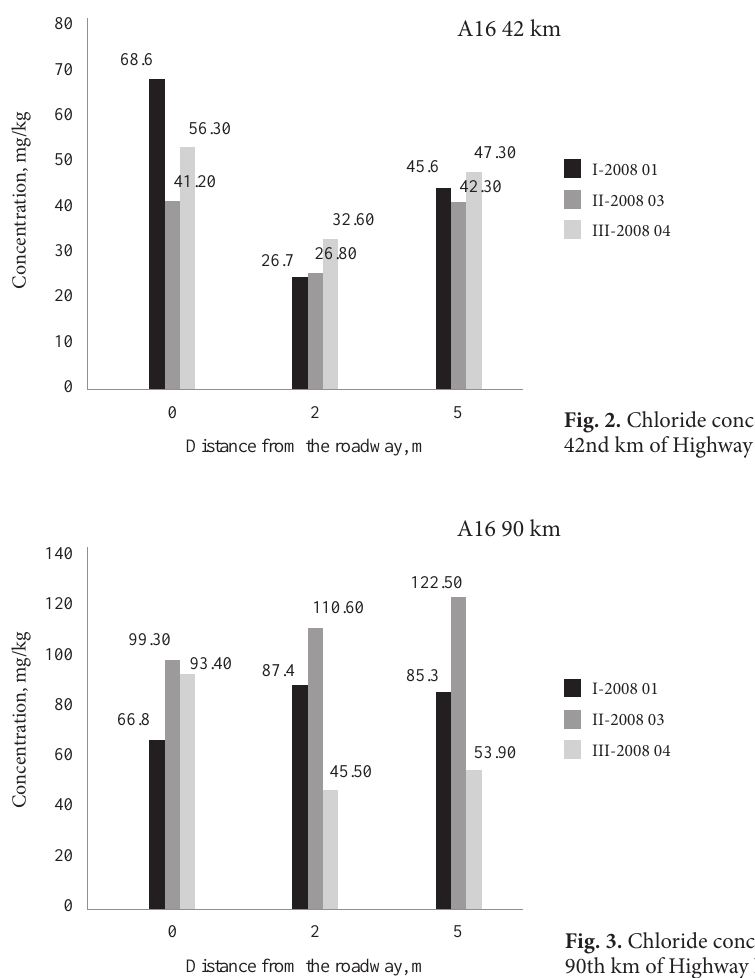
fig. 3. Chloride concentration in soil at 90th km of Highway No